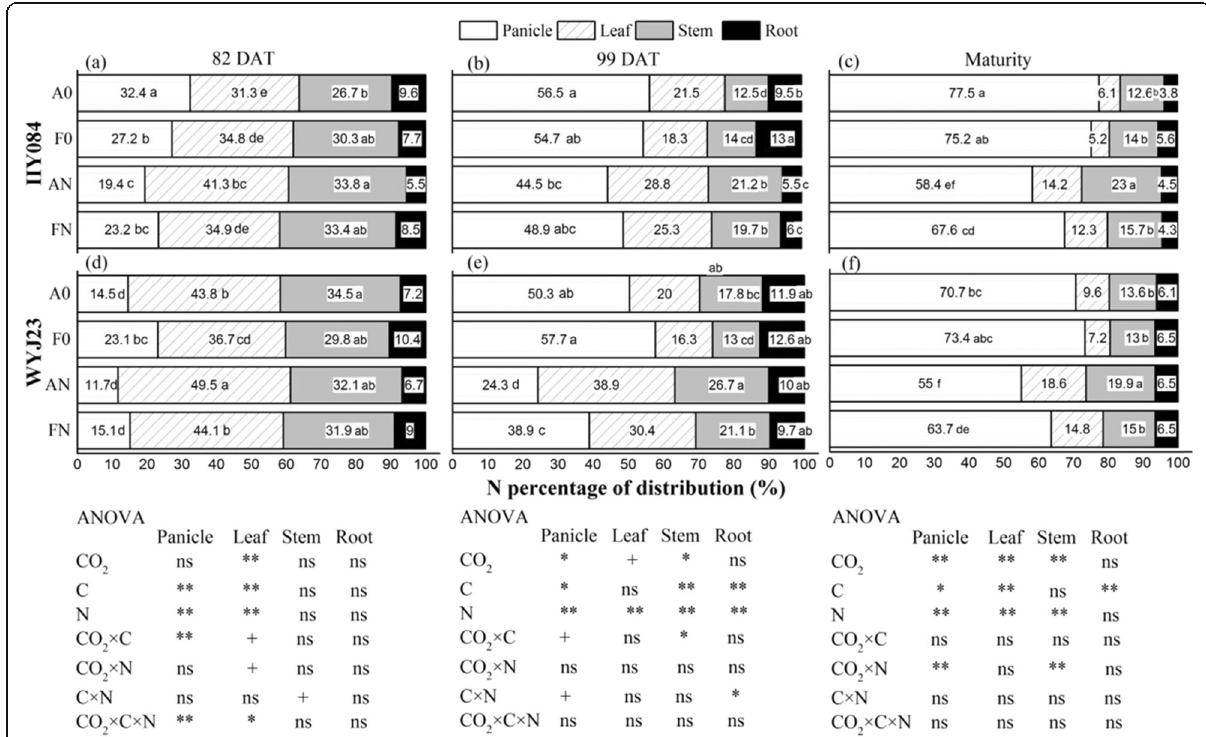
Fig. 4 The N allocation in four tissues of two cultivars (IIY084 and WYJ23) subjected to ambient (A) and elevated [CO 2 ] (F) at none (0N) and normal N levels (NN) at three stages and the results of three-way ANOVA (type III) (different letters represent significant differences in each tissue among eight treatments at each sampling date according to LSD at 5%